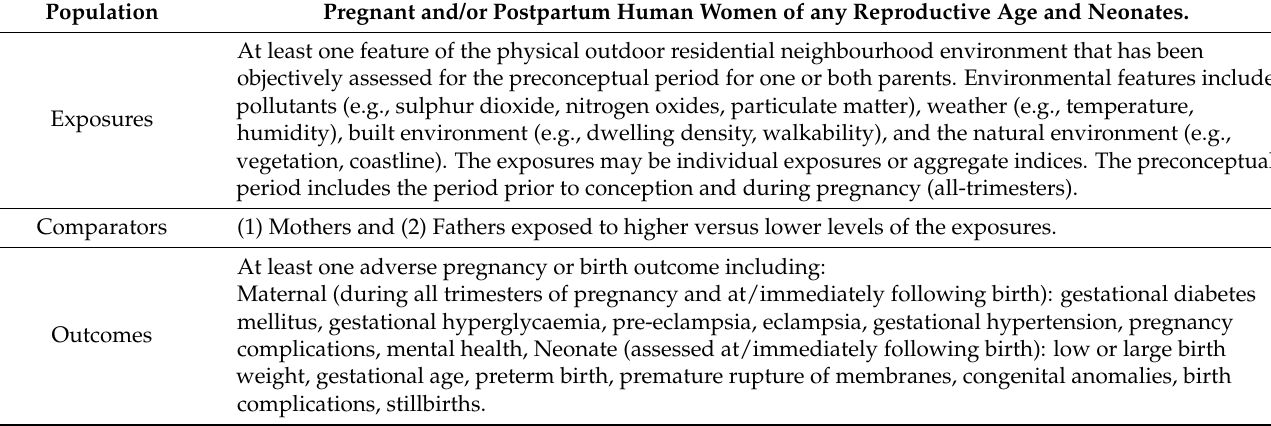
Table 1. Populations, Exposures, Comparators, and Outcomes (PECO)